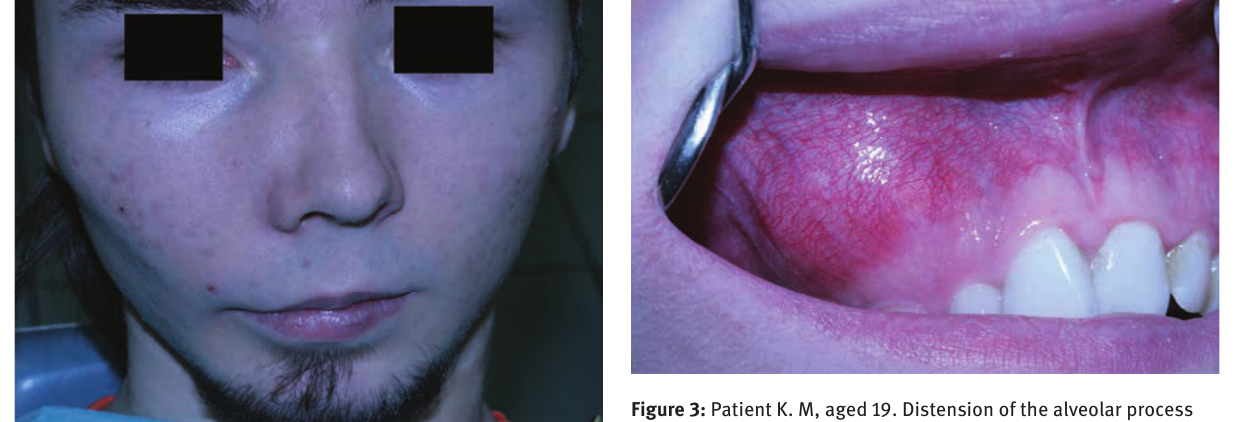
Figure 3: Patient K. M, aged 19. Distension of the alveolar process on right side of